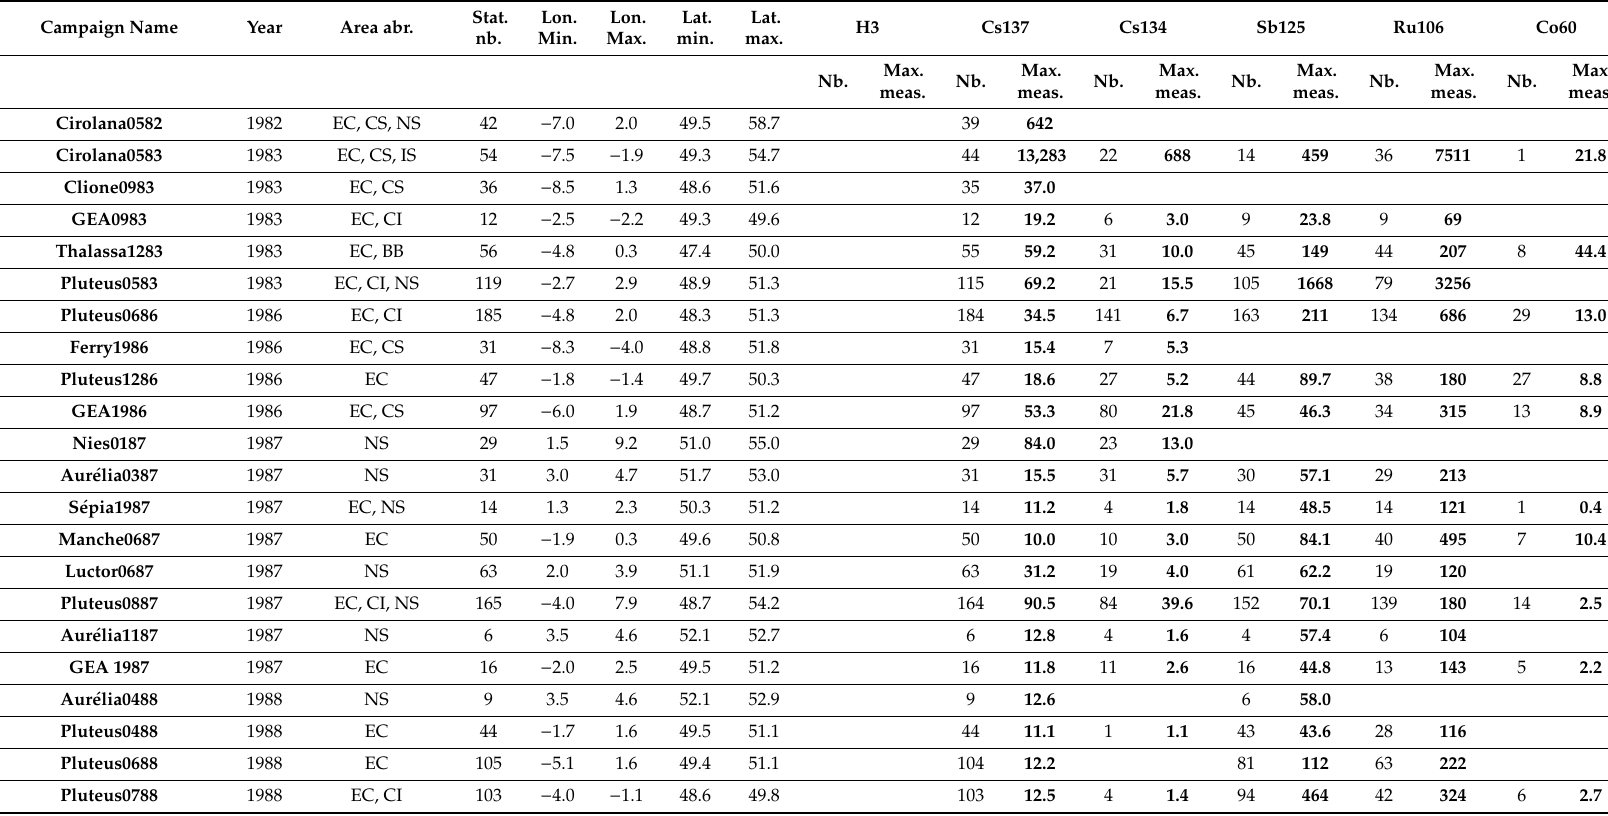
Table A1. List of oceanographic campaigns accounted in the database. Positions are referenced in WGS84 in decimal degrees (N, E: + ; S, W: − ). Radionuclide concentrations are in Bq · m − 3. Abbreviations: LH: La Hague Cape; EC: English Channel; CI: Channel Islands; CS: Celtic Sea; IS: Irish Sea; NS: North Sea; MS: Mediterranean Sea; BB: Biscay Bay; NA: North